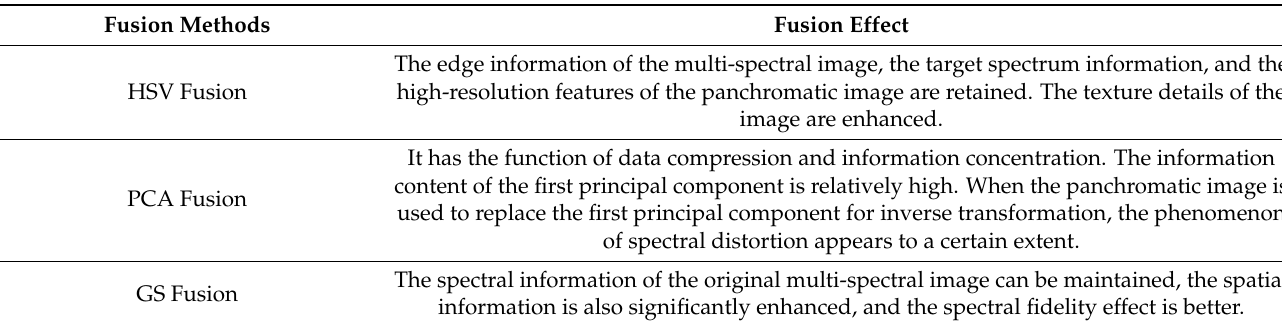
Table 3. Description of fusion